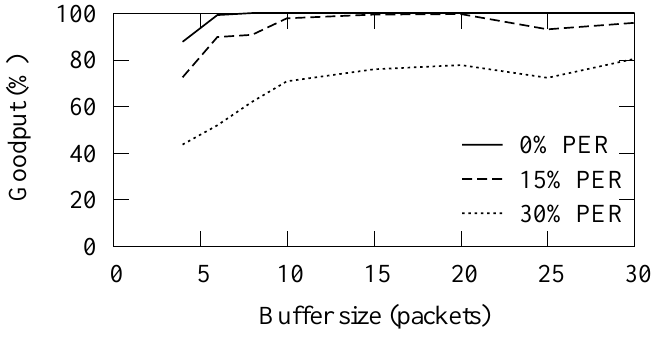
Figure 17. End-to-end reliability in TUTWSN with different buffer sizes (12 sources, 15 B/s offered